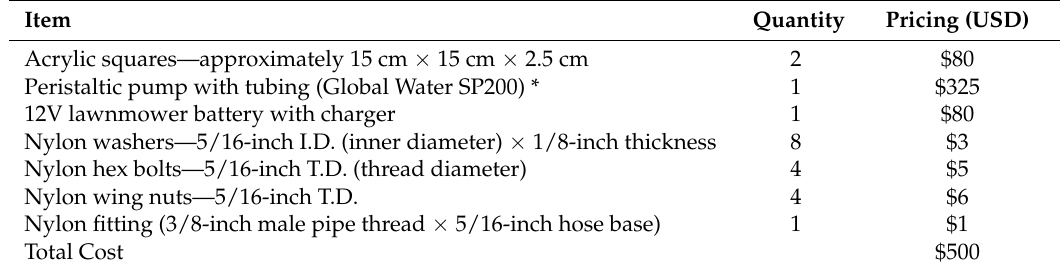
Table 1. Approximate total cost (in USD) for materials necessary to build the water sampler. Item Quantity Pricing (USD) Acrylic squares—approximately 15 cm × 15 cm × 2.5 cm 2 $80 Peristaltic pump with tubing (Global Water SP200) * 1 $325 12V lawnmower battery with charger Nylon hex bolts—5/16-inch T.D. (thread